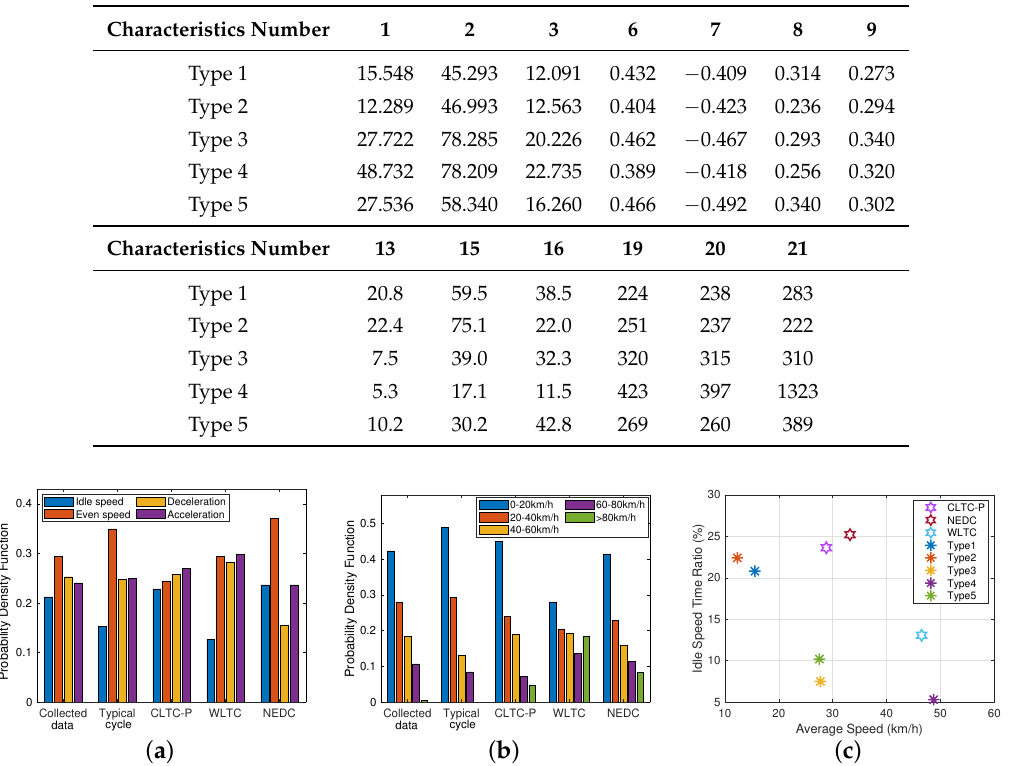
Table 5. Characteristics of five typical driving cycles.